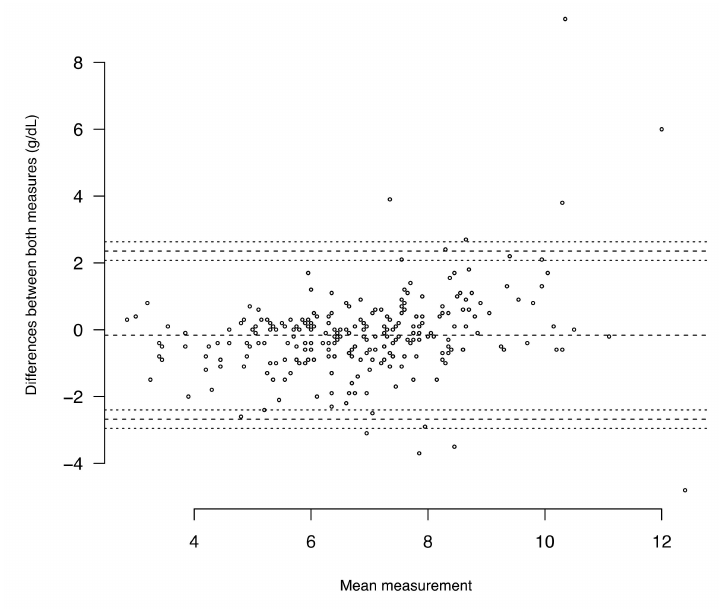
Figure 2. Concordance between pretransfusion Hb level (g/dL) depending on the measurement (point-of-care testing HemoCue vs. laboratory complete blood count with Bland and Altman graphic ( N = 253). Each dot shows the difference between the 2 measurements for a patient over the mean of these 2 values. Dashed lines are the mean of the differences and the limits of agreement (2 standard deviations) above and below that. (The mean of the differences was − 0.16 g/dL and the 2 SD were 2.35 g/dL and − 2.68 g/dL.) Dotted lines are the 95% confidence intervals of each limit of agreement (2.63; 2.08; − 2.40; − 2.95).